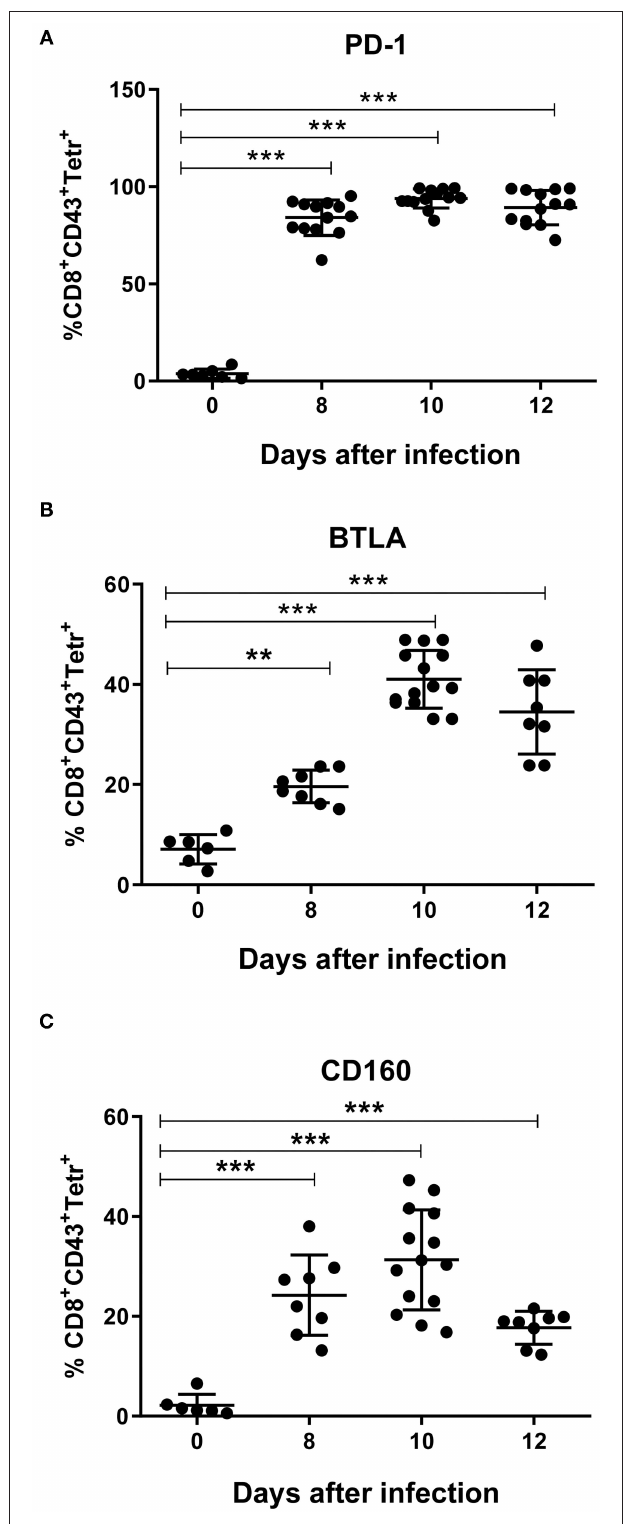
FIGURE 5 | Expression of inhibitory receptors on virus-specific CD8 + T cells. C57BL/6 mice were infected with FV complex and splenocytes were isolated